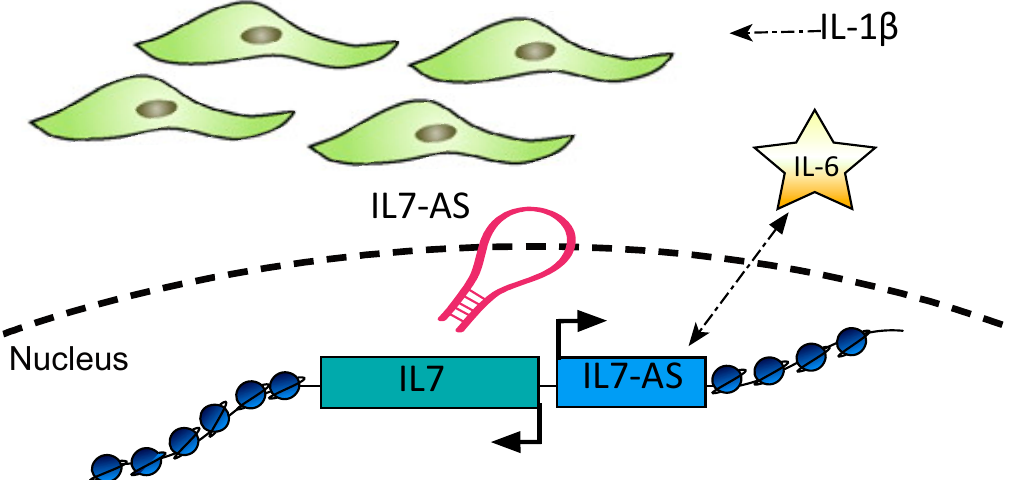
Figure 5. The antisense lncRNA, IL7AS, is upregulated upon IL-1 β exposure in human fibroblasts. Knock-down of IL7AS was shown to elevate both IL-6 mRNA and protein levels, indicating a significant role of this lncRNA in mediating the inflammatory response in human lung fibroblasts.